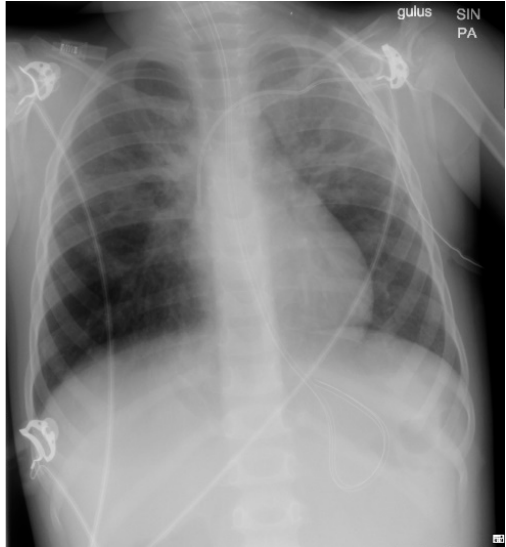
Figure 3. Day 2 Chest X-ray demonstrating decreased opacification bilaterally indicative of resolving pneumonia.